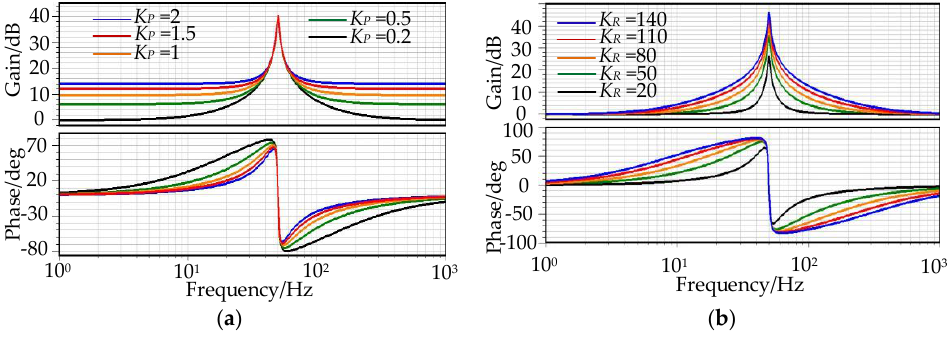
Figure 9. Frequency response considering parameter variation of PR controller. ( a ) Bode diagram at K P variation; ( b ) Bode diagram at K R variation.